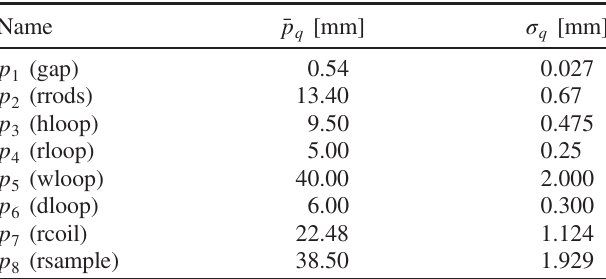
TABLE I. Means ¯ p inputs.